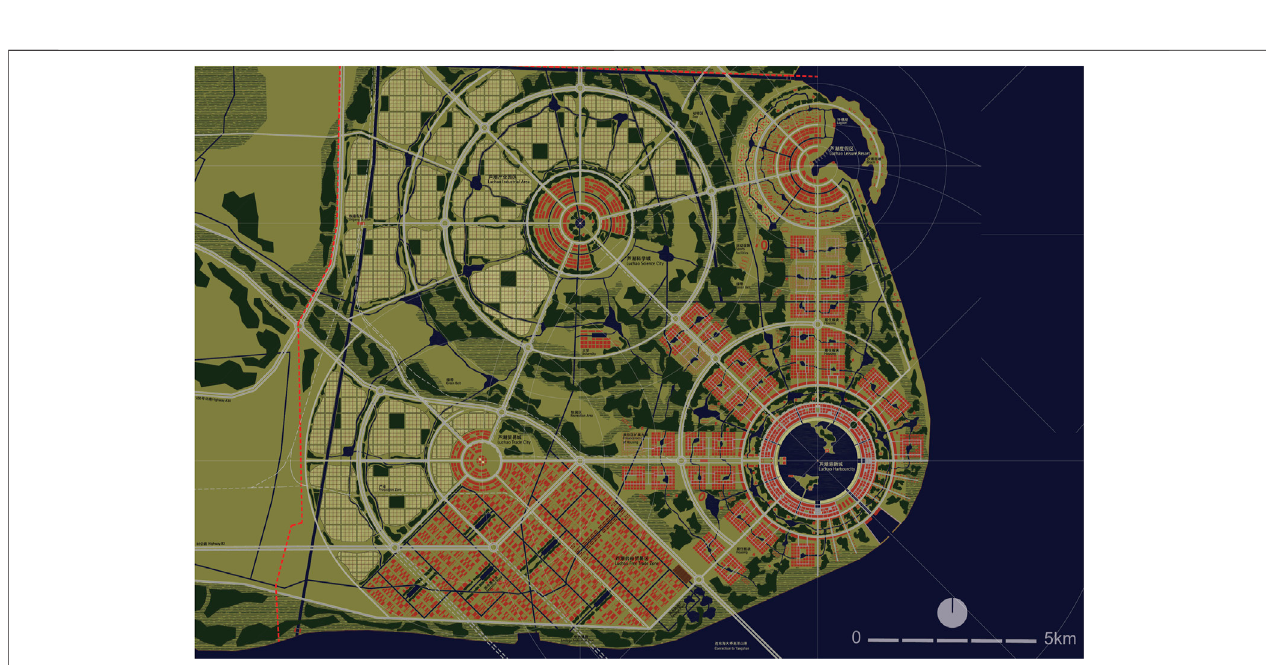
FIGURE 7 | Ecological ‘ stepping-stone along the Huangpu River at the former World Expo 2010 site (Photo by author, March 2020.